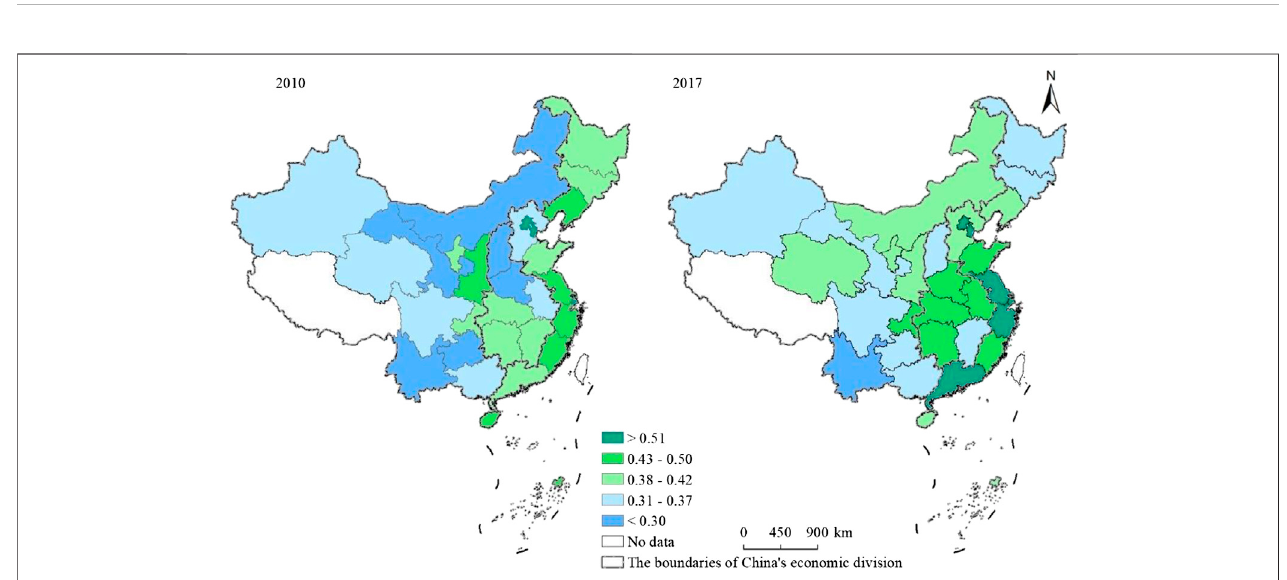
FIGURE 3 | Spatial distribution of green urbanization in 2010 and